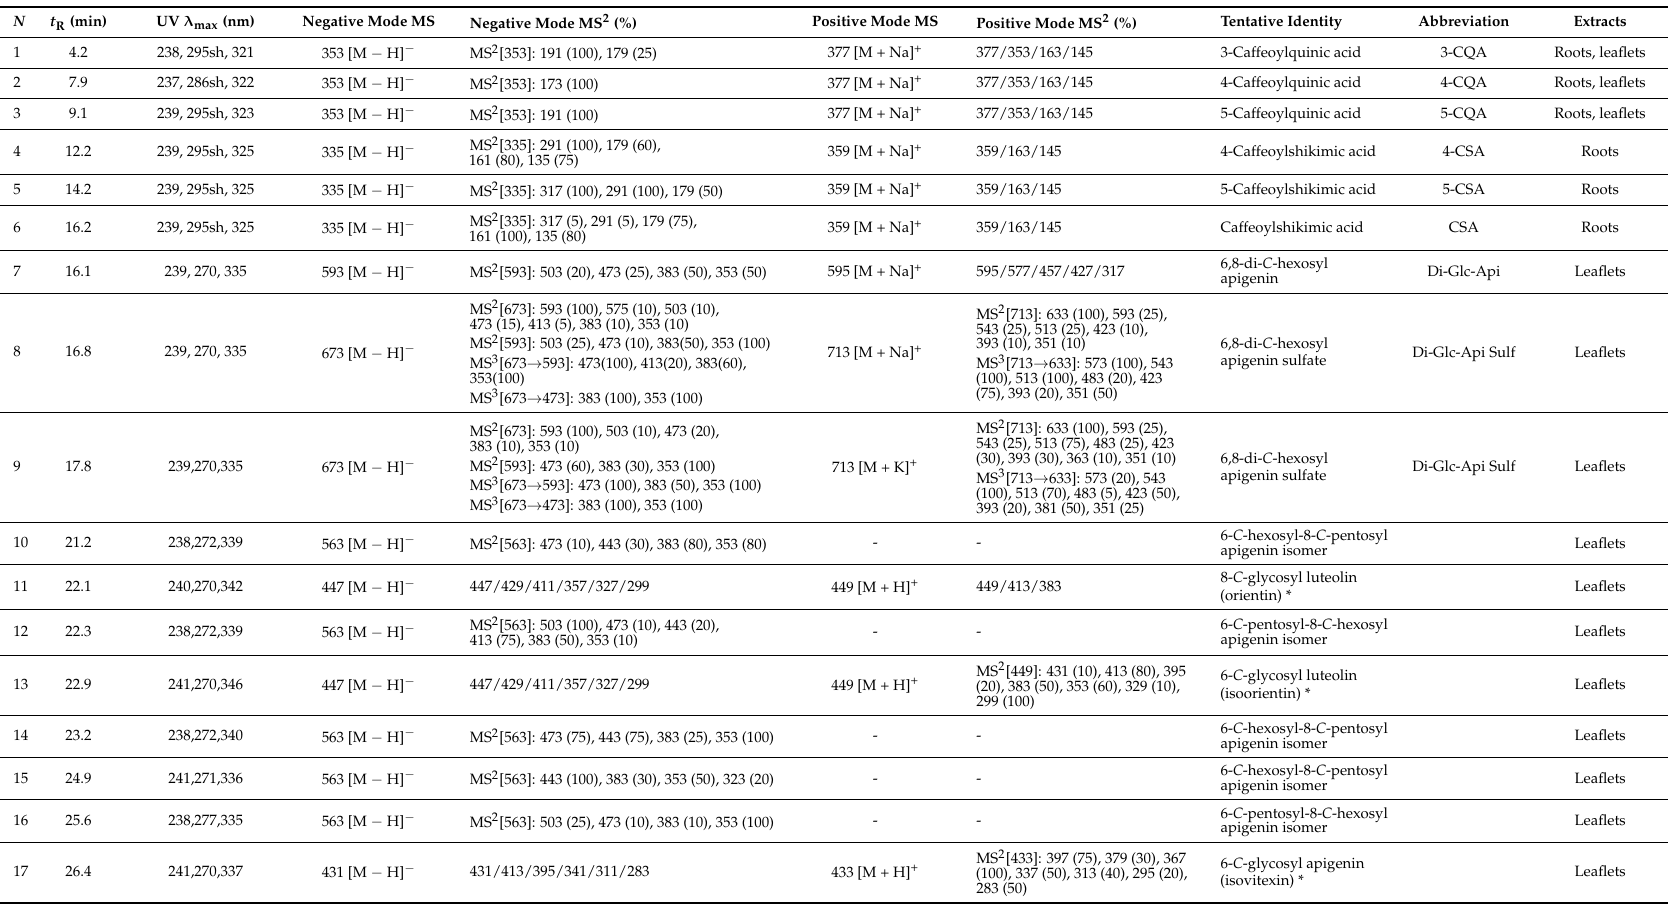
Table 2. Identification of main components of root and leaflet extracts of Euterpe oleracea